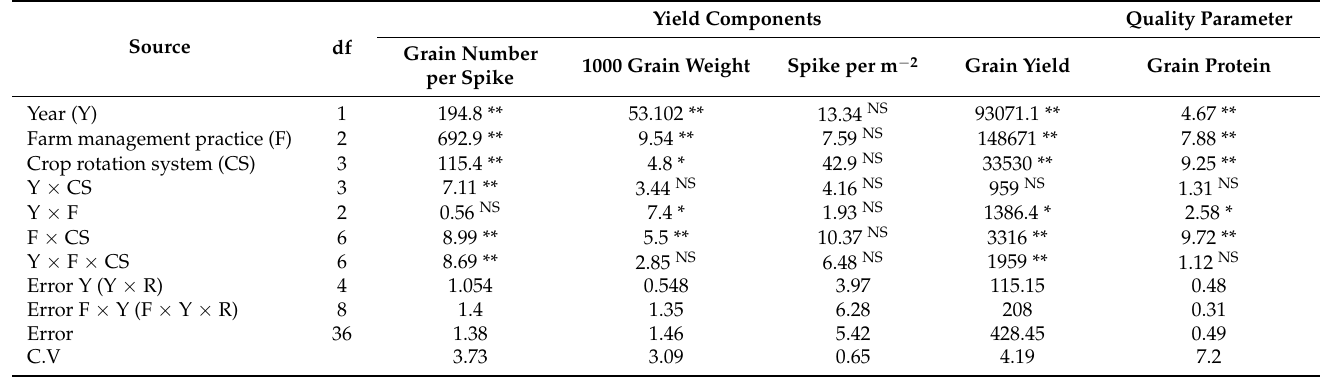
*, ** indicate significantly different at p ≤ 0.05 and p ≤ 0.01, respectively; NS , no significant difference by Duncan test based on a mixed split-plot statistical